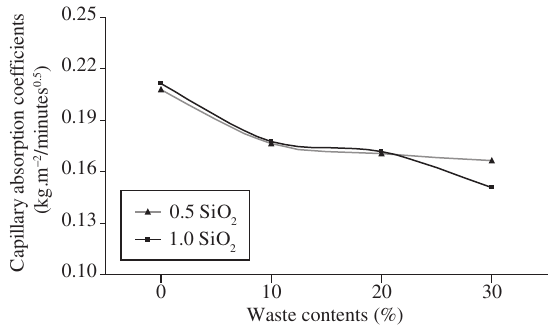
Figure 7. Capillary absorption coefficients of magnesium phosphate cement mortar as a function of sand and grinding dust